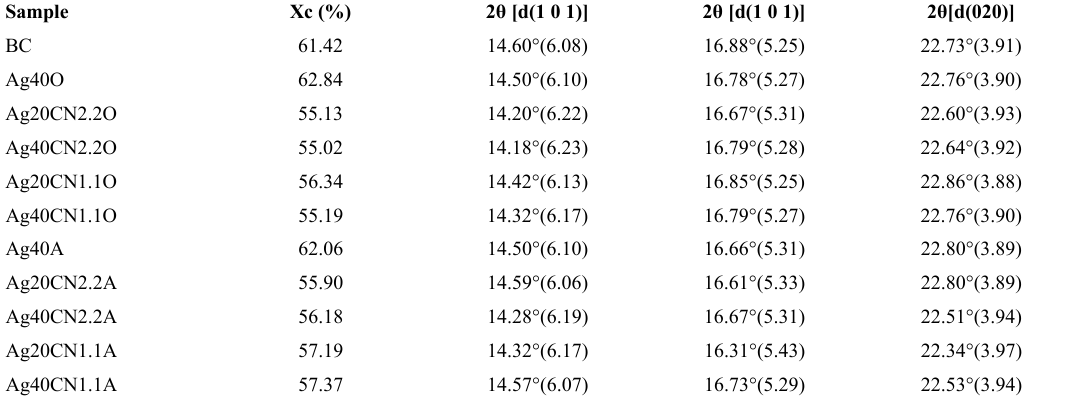
Figure 10. X-ray diffraction patterns of the neat and functionalized BC membranes submitted to different thermal treatments: a) oven; b) autoclave. Table 4. Data obtained from XRD for the BC membranes submitted to different thermal treatments: crystallinity degree, reflective-angle, Sample